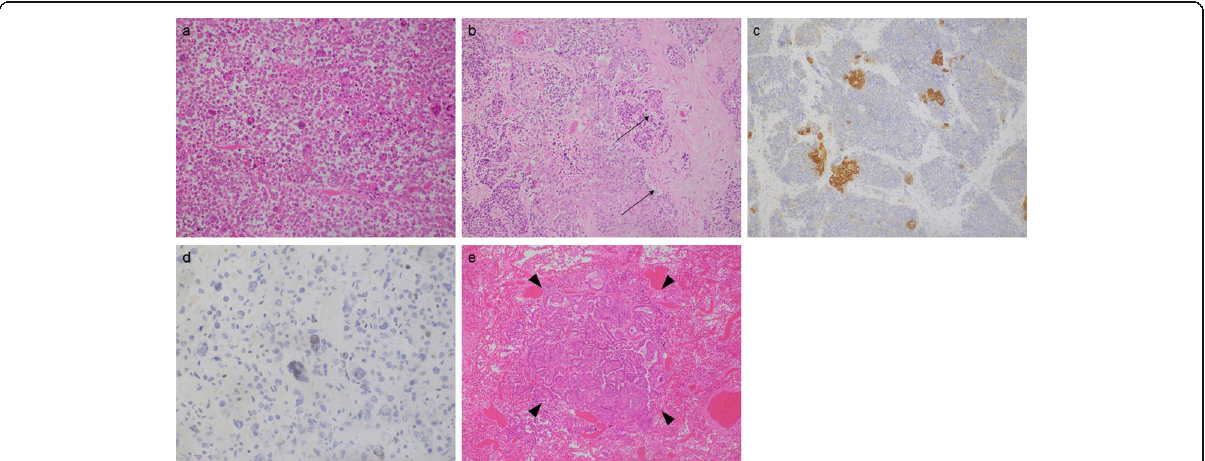
Fig. 2 Pathological findings of the autopsy samples. a Tumor composed of pleomorphic spindle cells with eosinophilic cytoplasm and polymorphonuclear cell infiltration. (Hematoxylin and eosin stain, × 20). b Tumor cells with squamous differentiation (arrow) in the regional lymph node. (Hematoxylin and eosin stain, × 20). c Cytokeratin AE1/AE3-positive lesion shows squamous differentiation (× 20). d PAX-8 sporadically positive in the atypical lesion (× 40). e Tumors in the lung reveal morphology of typical papillary thyroid carcinoma (arrowhead). (Hematoxylin and eosin stain, ×